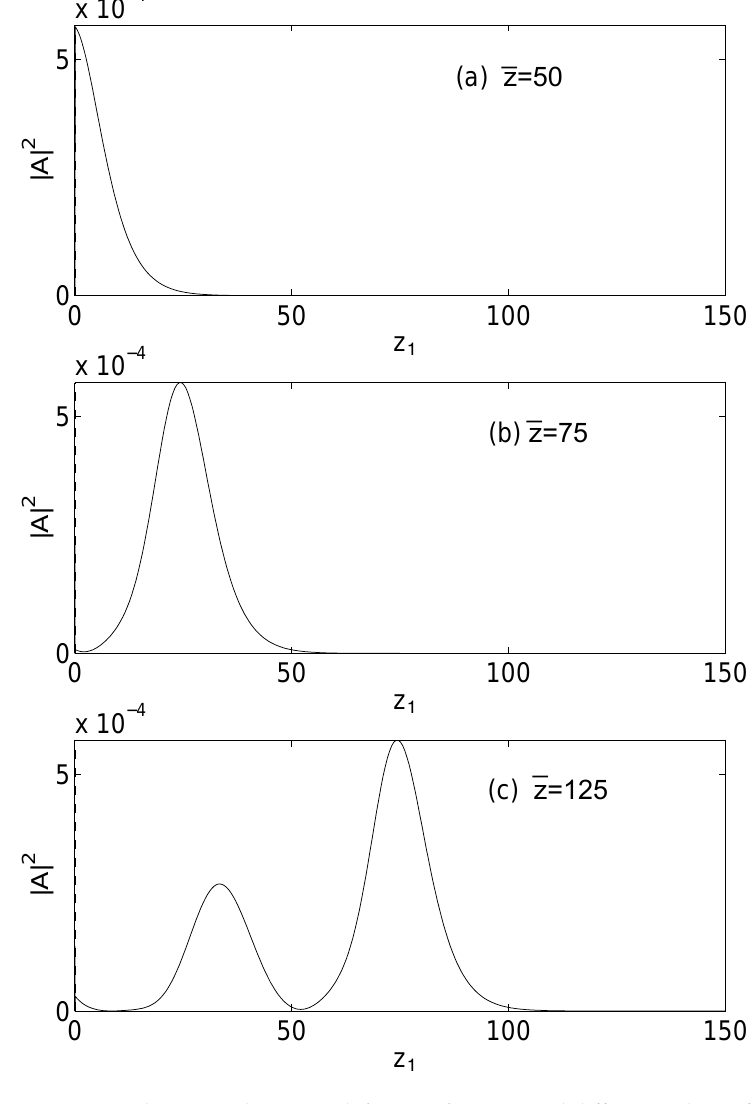
Figure 6. Weak superradiance, with l b = 0.1 l c , δ = 0 and different values of ¯ z : ( a ) ¯ z = 50; ( b ) ¯ z = 75; ( c ) ¯ z =